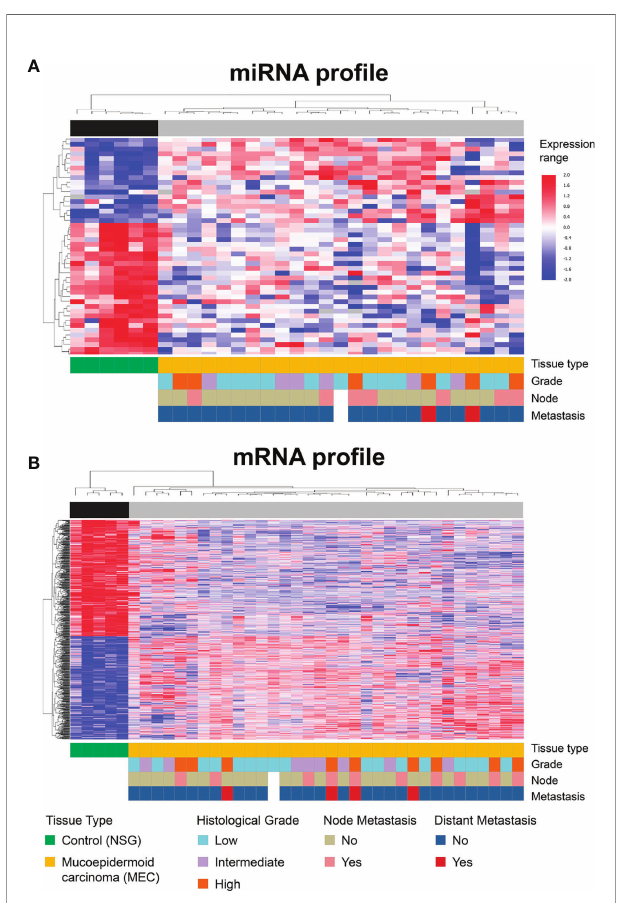
FIGURE 3 | Supervised hierarchical clustering analysis considering the miRNA (A) and mRNA (B) expression pro fi les. The dendrograms show a complete separation between MEC and NSG samples according to the 47 miRNAs (A) and 3,162 mRNA differentially expressed (B) . The samples are represented in columns and miRNAs/genes in